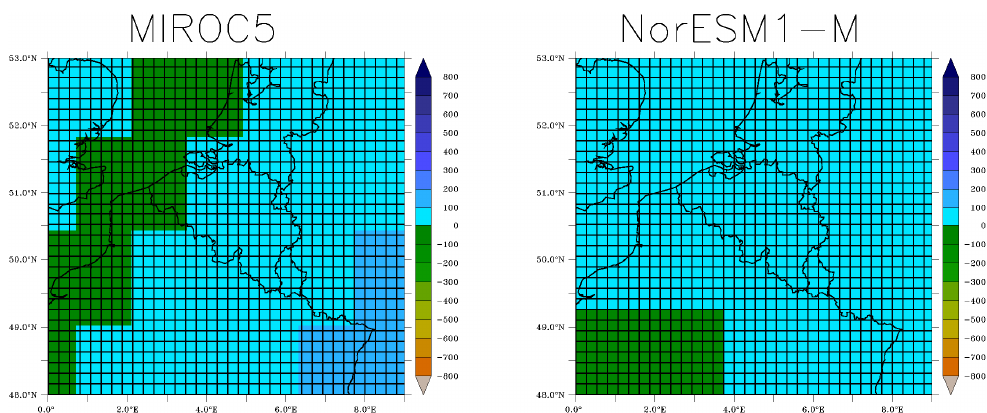
Figure 7. Annual precipitation anomalies (in mm/year) between the future period 2070–2100 and the present period 1987–2017 from MIROC5 (left) and NorESM1-M (right). Cross-hatched pixels indicate that values are statistically insignificant.